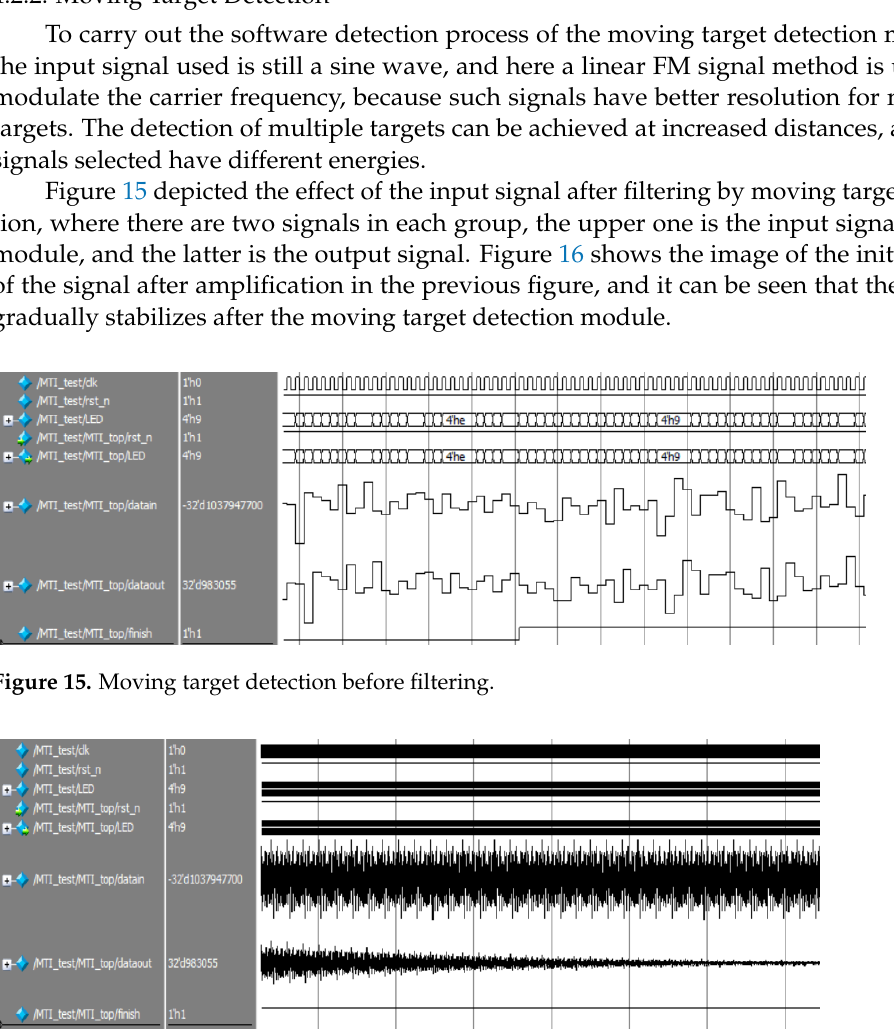
Figure 14. Threshold detection resource occupancy.